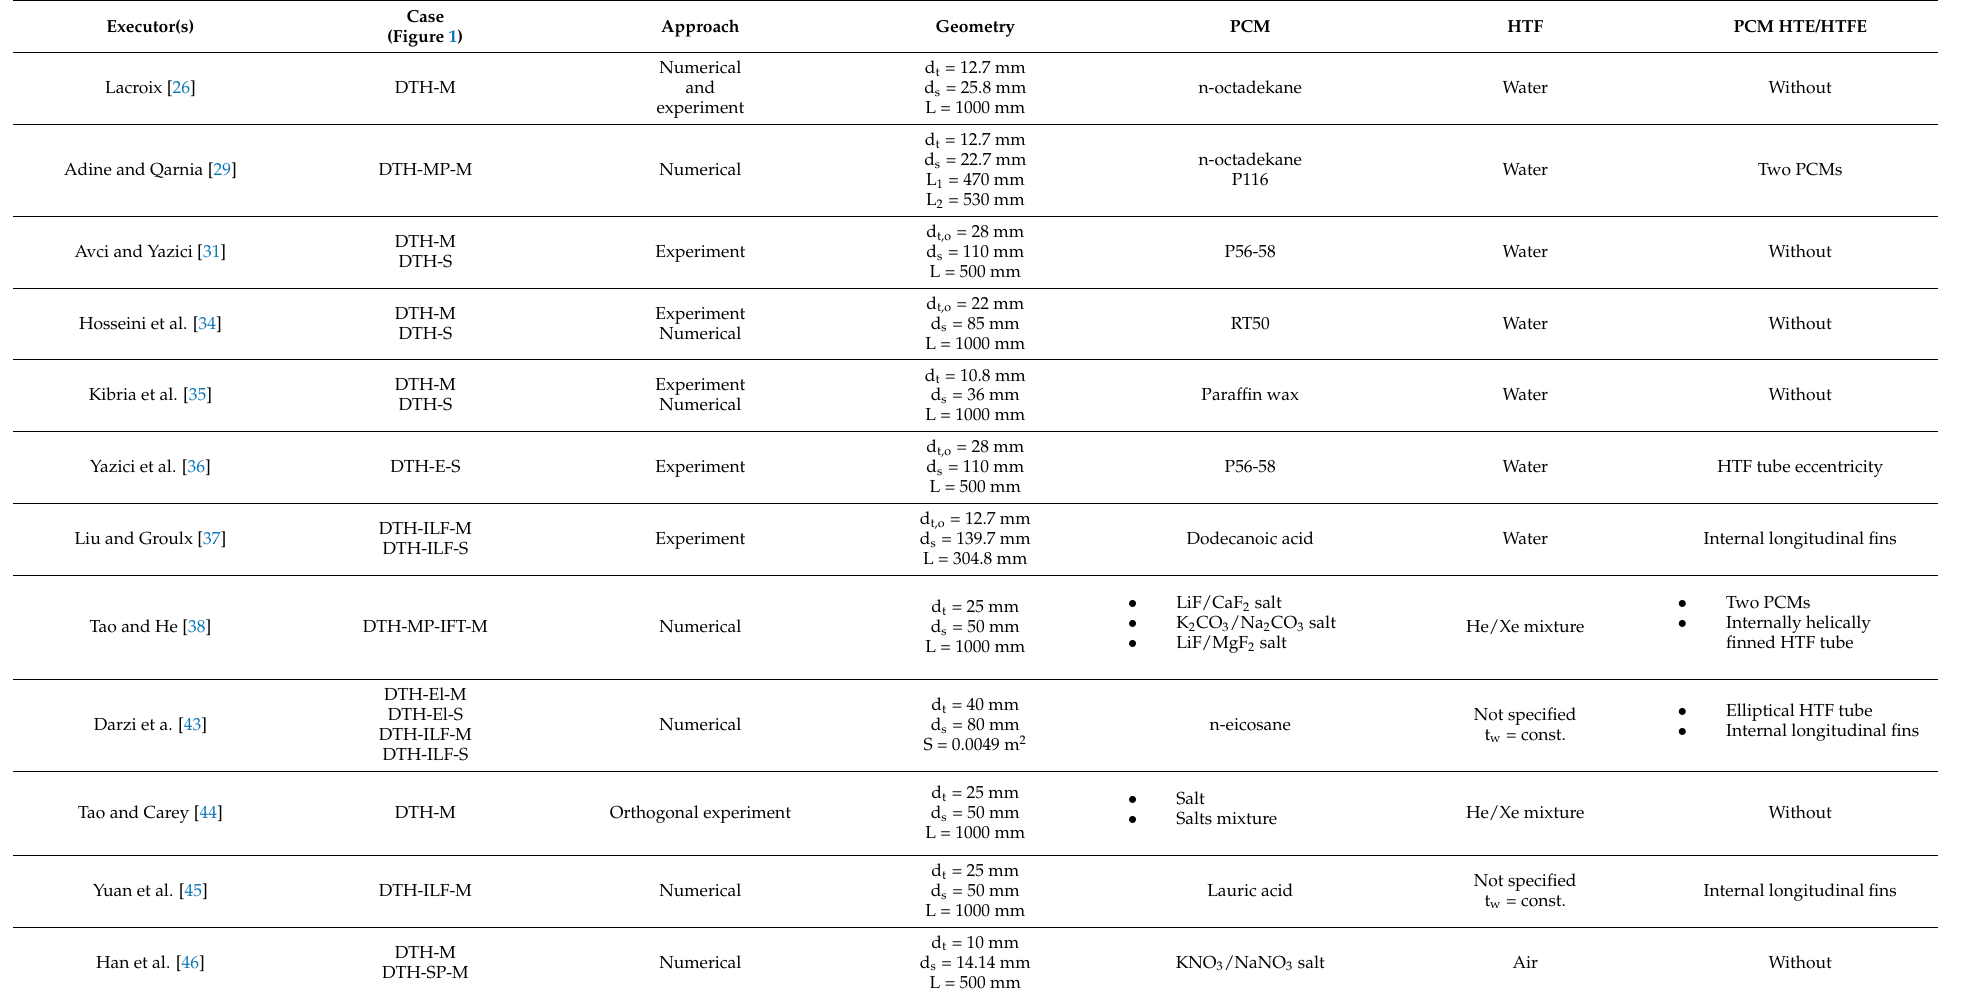
Table 1. Studies dealing with horizontal double-tube